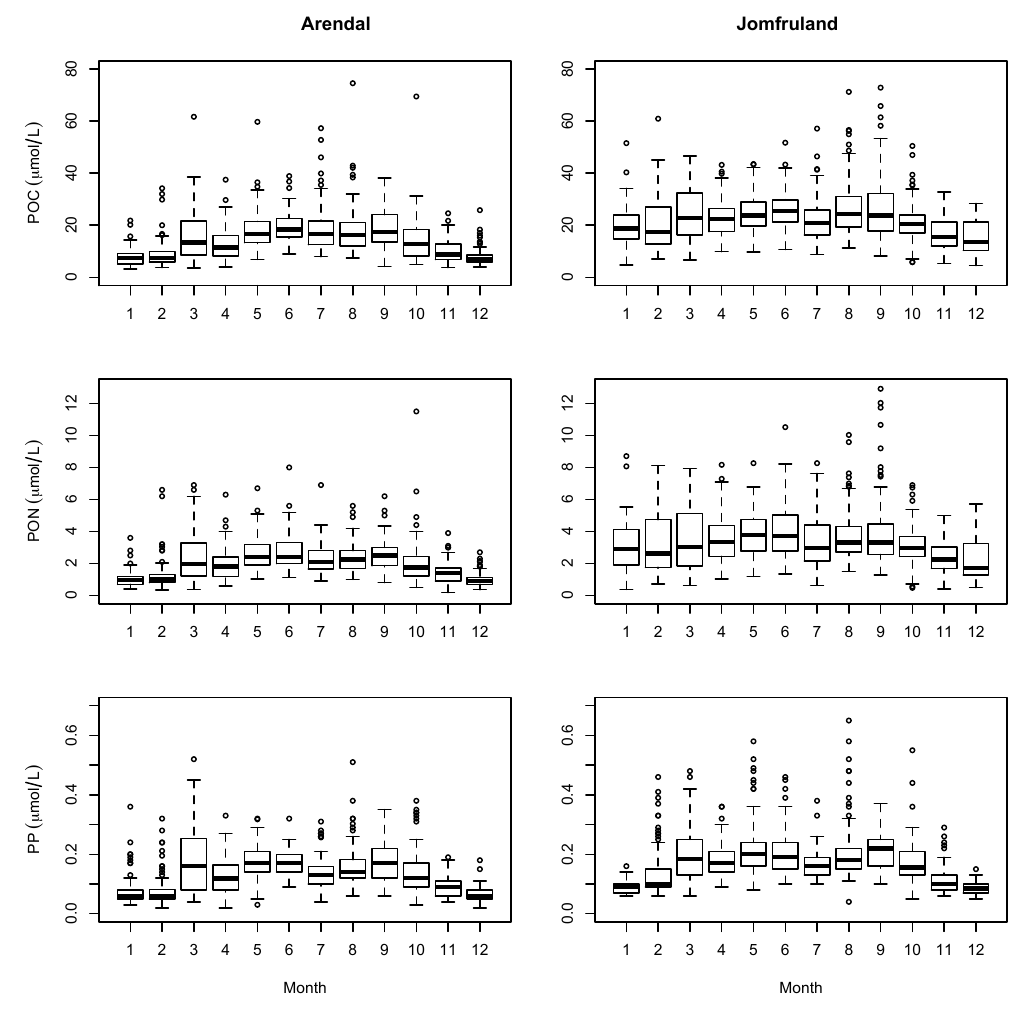
Fig. 3. Box-and-whisker plots showing the seasonal concentrations of POC, PON and PP at Arendal and Jomfruland. All concentrations are inµmoll − 1